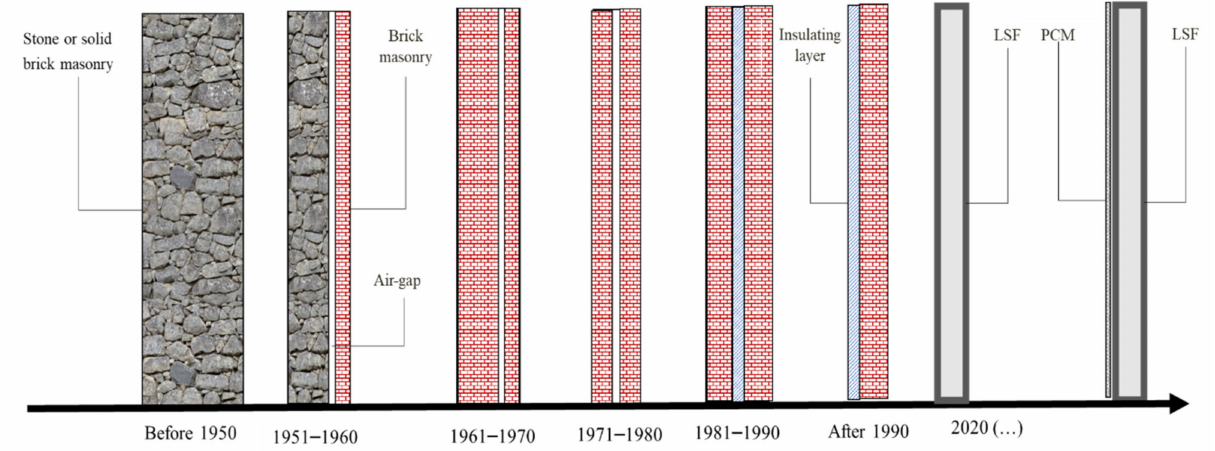
Figure 3. Evolution of external wall constructive